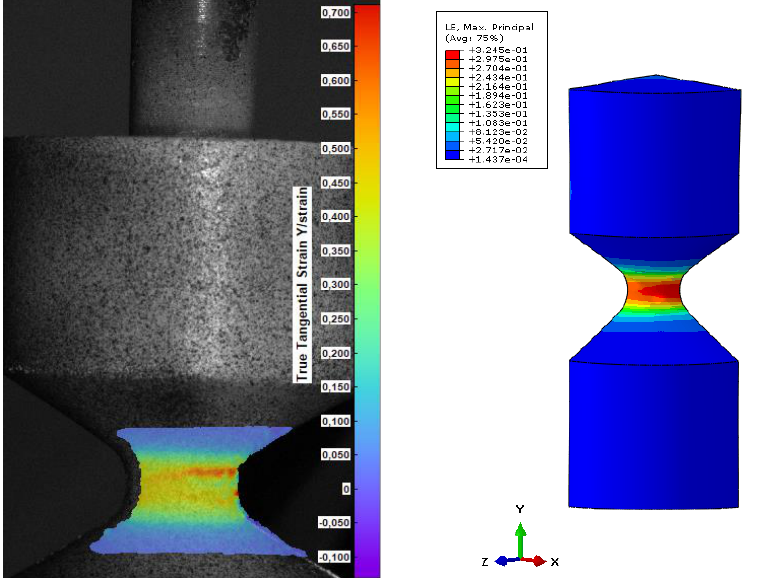
Figure 11. Comparison of DIC and FEM in terms of the obtained value of strain for step 60 (force DIC = 591 N, FEM force = 828 N).